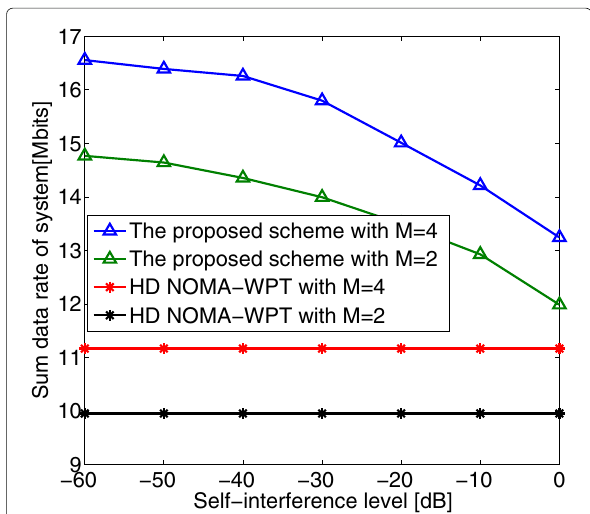
Fig. 7 Sum data of system versus self-interference